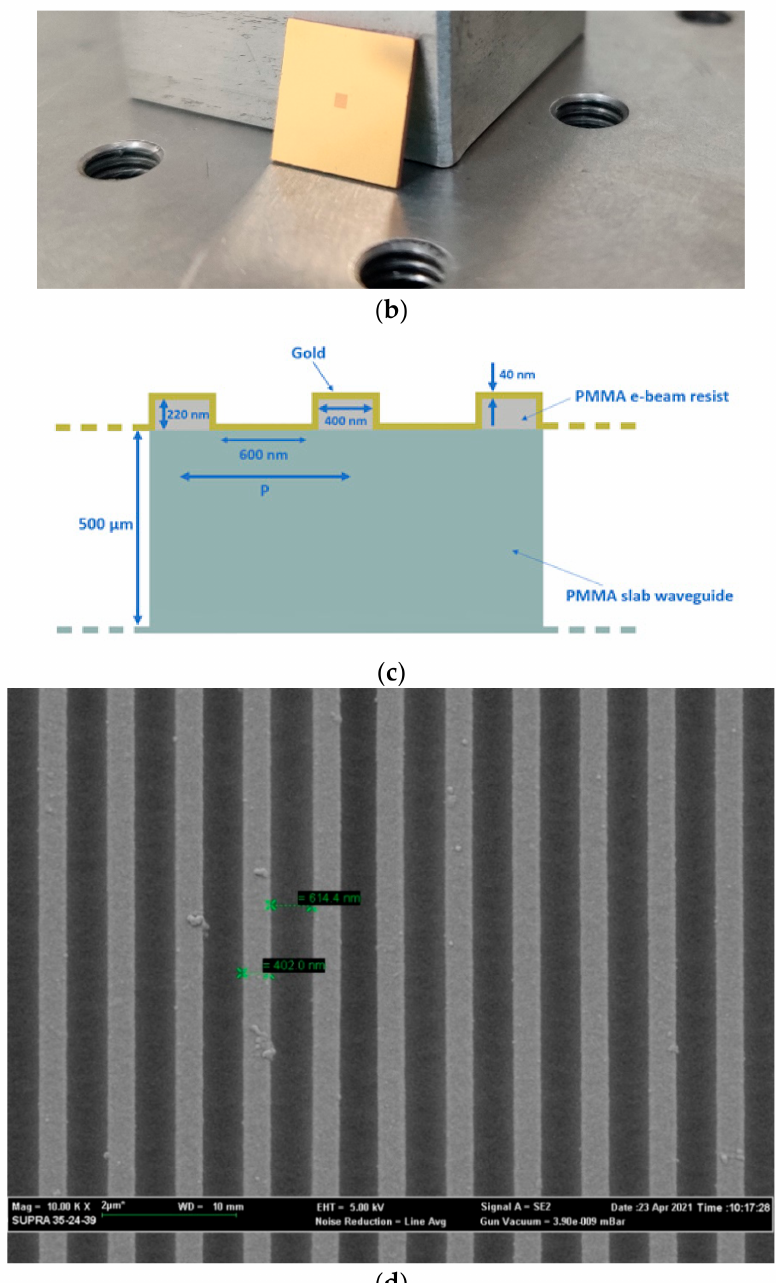
Figure 1. ( a ) Outline of the fabrication process of the plasmonic sensor. ( b ) picture of the PMMA slab waveguide with gold nanograting pattern at the center. ( c ) Schematic cross section of the examined plasmonic GNG-based chip with the relative dimensions. ( d ) SEM image of the fabricated nanograting. The bovine serum albumin (CAS 9048-46-8) and trypsin (CAS 9002-07-7) were from Sigma-Aldrich (Darmstadt,